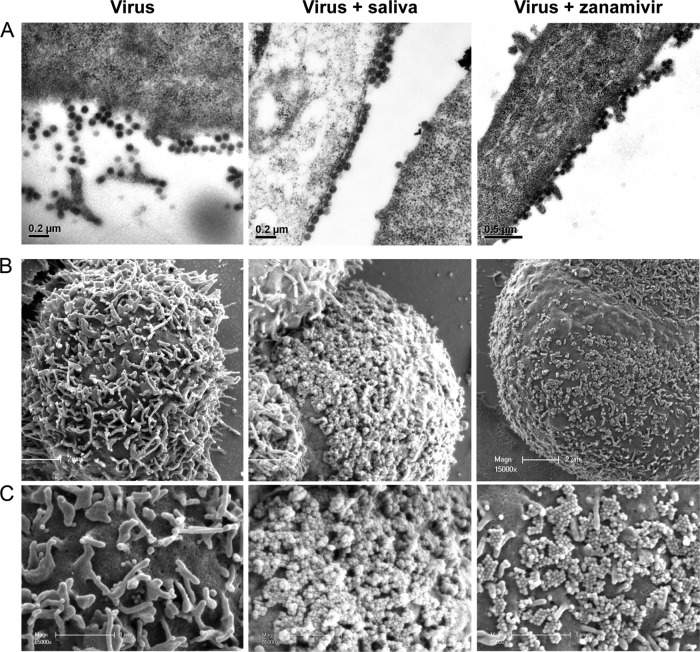
Electron microscopy of saliva-treated infected MDCK cells. (A) MDCK cells were exposed to PR8 virus (MOI = 10) in RPMI plus antibiotics for 1 h at 37°C and then washed thoroughly and cultured in the presence of medium, untreated saliva (1:2 final dilution), or 50 ng/ml of zanamivir for a further 10 h at 37°C. The cells were then fixed and embedded in resin. Ultrathin sections were stained and visualized by TEM. (B) Alternatively, MDCK cells were infected and seeded onto gold-coated coverslips. After 10 h of incubation as described above, the coverslips were fixed and visualized by SEM. (C) Higher-magnification (×65,000) images of the cell surfaces in panel B.